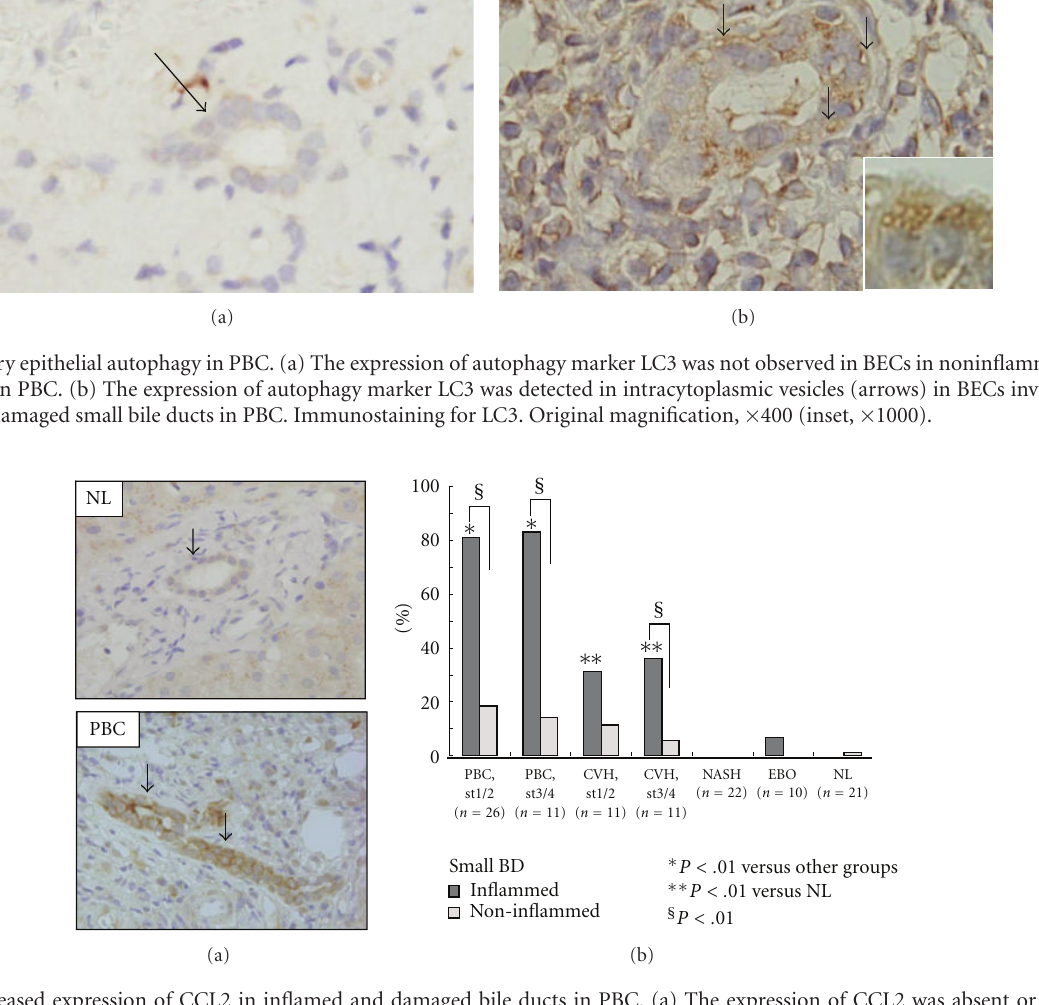
Figure 4: Increased expression of CCL2 in inflamed and damaged bile ducts in PBC. (a) The expression of CCL2 was absent or faint in biliary epithelial cells (BECs) in the small bile duct (arrow) in normal liver (top). CCL2 was extensively expressed in the membrane and cytoplasm of damaged and senescent BECs (arrows) in the early stage of PBC (bottom). Immunostaining for CCL2. Original magnification, × 400. (b) The expression of CCL2 was significantly more frequent and intense in inflamed small bile ducts in PBC, when compared with noninflamed small bile ducts in PBC and small bile ducts in control livers ( P < . 01). CVH: chronic viral hepatitis; NASH: nonalcoholic steatohepatitis; EBO: extrahepatic biliary obstruction; NL: normal